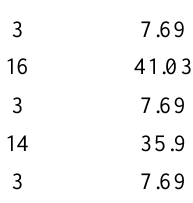
Willingness to Develop Open Textbooks Willingness to develop OER derived custom-built open